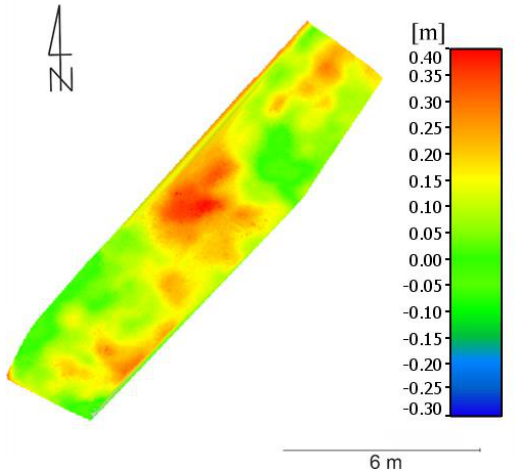
Figure 16. Distribution of differences in the height of the point cloud in relation to the reference model (Test Area No. 1).